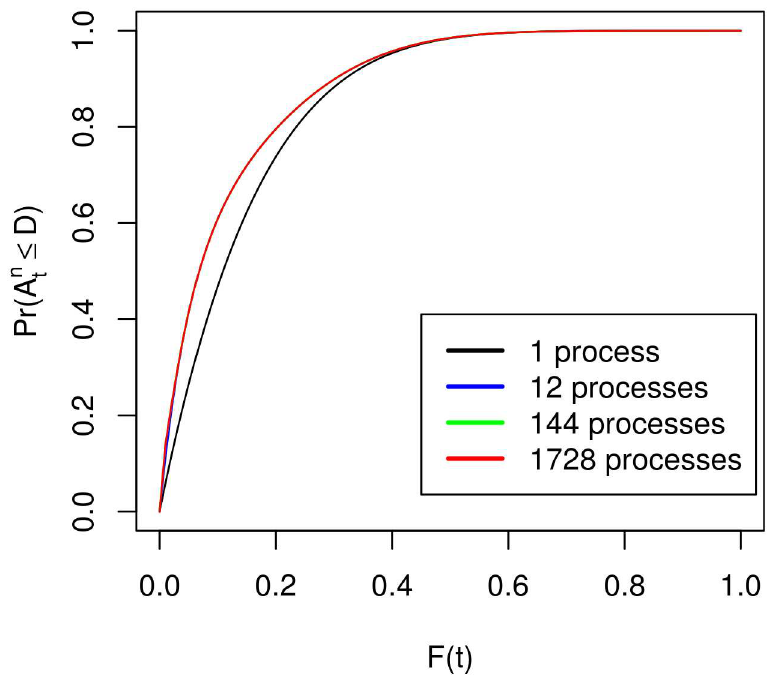
Fig 4. Probabilities in the case of unequal restart times. For 6 restarts.